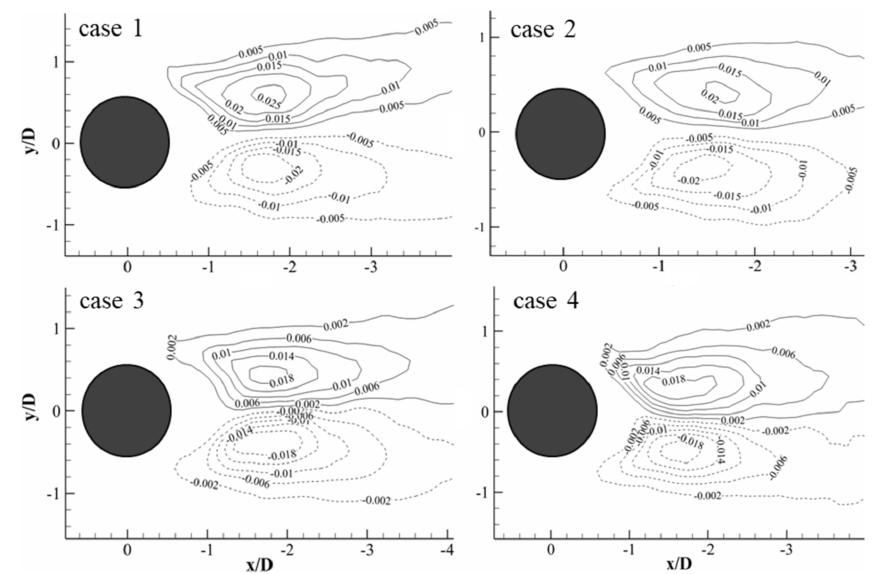
Figure 4. The distribution of Reynolds stress for the smooth cylinder and the dimpled cylinder with different numbers. case 1: Smooth cylindrical; case 2: Dimpled columns is 4; case 3: Dimpled columns is 8; case 4: Dimpled columns is 12.